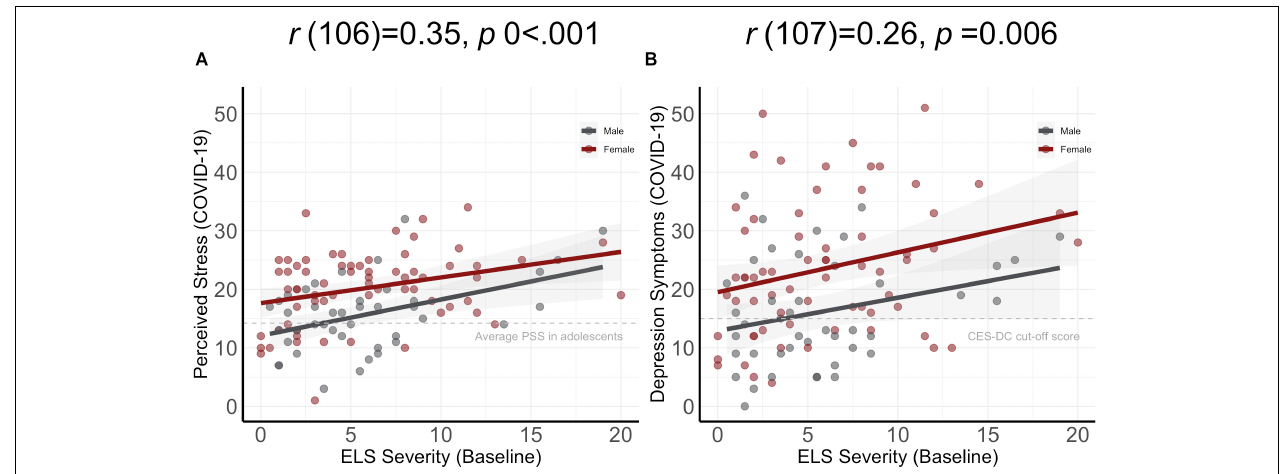
FIGURE 3 | Severity of ELS assessed at baseline is significantly associated with PSS (A) and CES-DC (B) scores at the COVID-19 assessment. The shaded areas represent 95% confidence intervals of the regression lines.